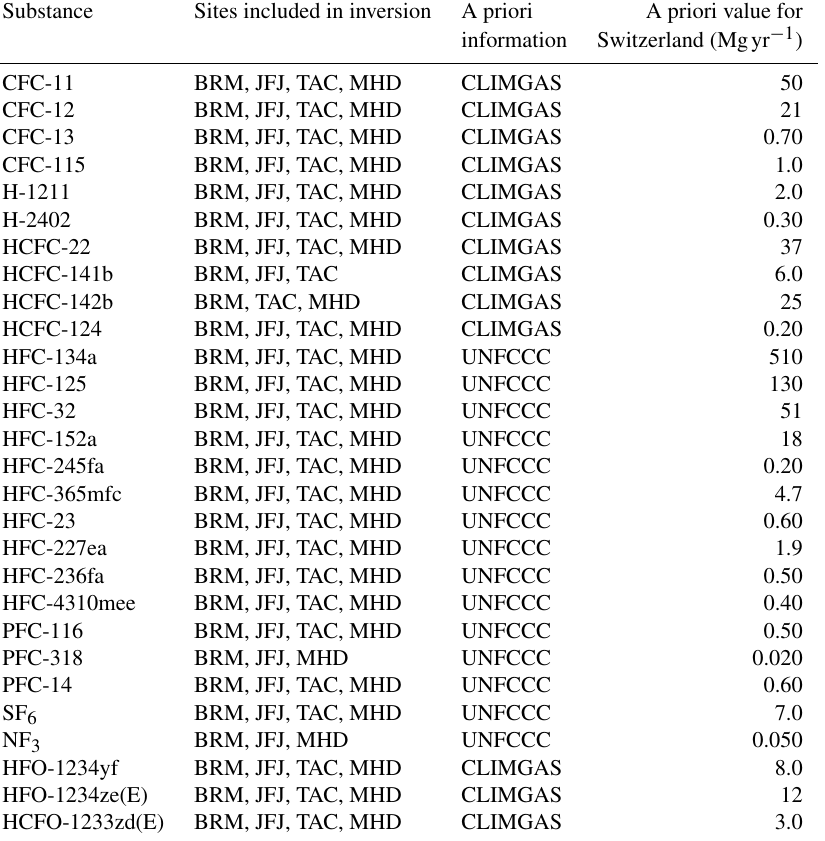
Table 1. For each halocarbon, the following information is listed: the measurement sites included in the Bayesian inverse (BI) modelling, i.e. Beromünster (BRM), Jungfraujoch (JFJ), Tacolneston (TAC), and Mace Head (MHD), and the source of the a priori value, i.e. either taken from the Swiss inventory as reported to the UNFCCC (UNFCCC, 2021) or taken from the results calculated within the CLIMGAS-CH project based on the Jungfraujoch measurements (Reimann et al., 2021; Reimann, 2021). The respectively used a priori value for Switzerland is rounded to two significant